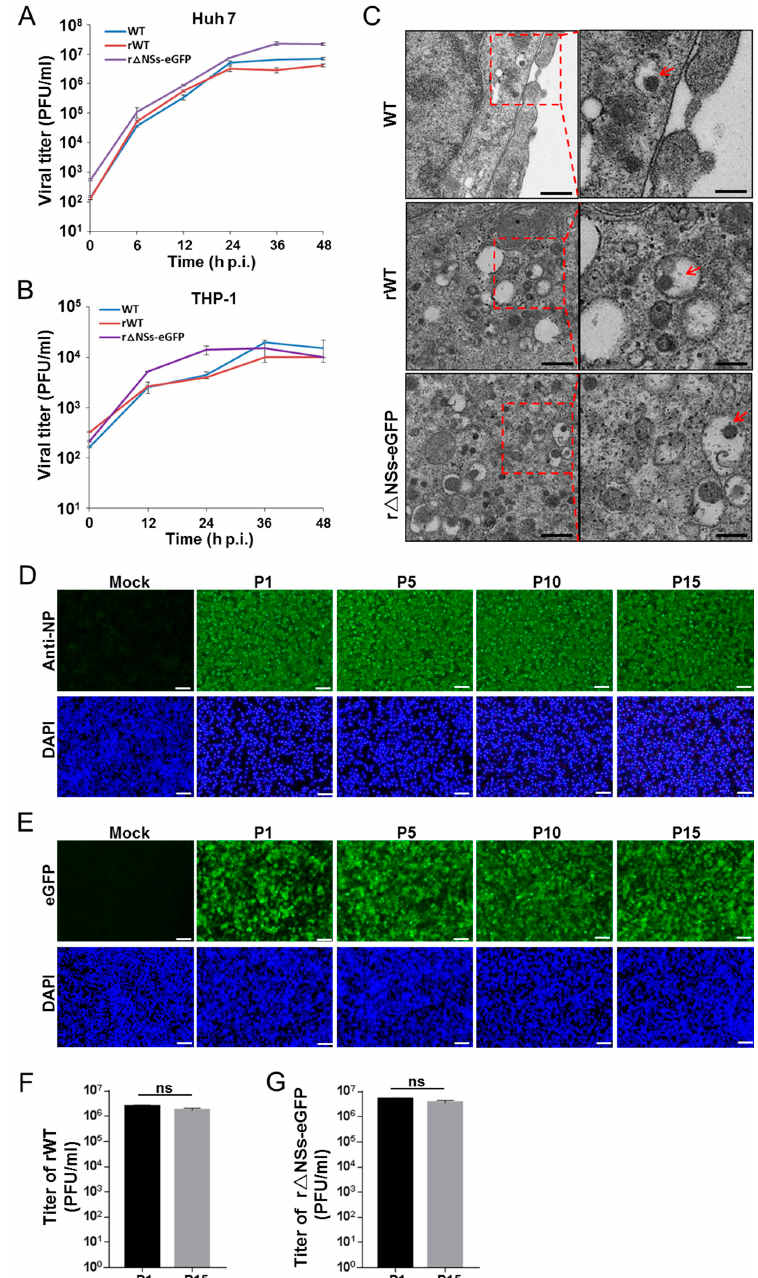
Figure 2. Characterization of rescued recombinant viruses. ( A , B ) One-step growth kinetics of WT, rWT and r (cid:52) NSs-eGFP in Huh7 ( A ) and THP-1 cells ( B ). Cells were infected with a 0.1 MOI for Huh7 or 1 MOI for THP-1, and supernatants were collected at indicated time points. Viral titers were detected by plaque assay on Vero cells; error bars represent standard deviation. ( C ) EM analysis of progeny virus formation. Huh7 cells were infected with WT, rWT or r (cid:52) NSs-eGFP. At 24 h p.i., cells were fixed and observed by TEM. The images show that virus particles were located in the cytoplasm of infected cells. Right panels are enlarged pictures of the boxed regions, red arrows indicate virus particles. Bars are 1 µ m (left panels) and 500 nm (right panels). ( D , E ) Immunofluorescence and fluorescence microscopy to detect rWT ( D ) and r (cid:52) NSs-eGFP ( E ) infection in BHK-21 cells from each passage. The images were taken from di ff erent passages. Green fluorescence indicates infection. P1 represents the first passage; P5, the fifth passage; P10, the tenth passage; and P15, the fifteenth passage. Bars, 50 µ m. ( F , G ) The virus titer of rWT ( F ) and r (cid:52) NSs-eGFP ( G ) from indicated passage numbers in BHK-21 cells was detected by plaque assay. P1, the first passage; P15, the fifteenth